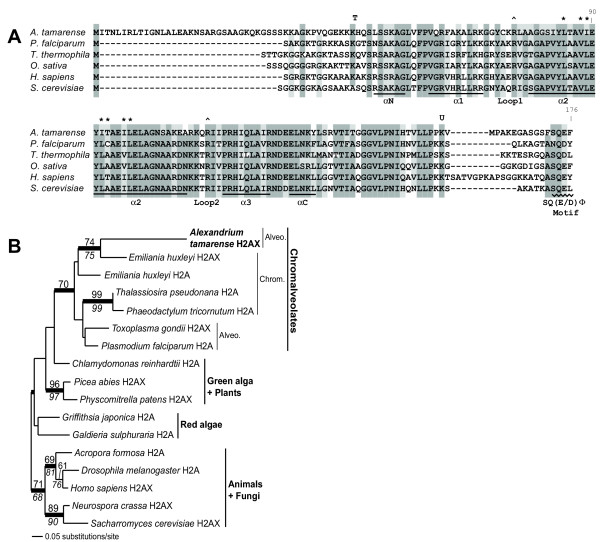
Analyses of A. tamarense histone H2A.X. A) Alignment of A. tamarense H2A.X with eukaryotic homologs. The alignment is shaded according to the level of conservation. The symbols above the alignment indicate the location of functional residues (T = trypsin cleavage site, ^ = arginines that contact the DNA helix, * = H2A-H2B interaction sites, U = ubiquitination site). The annotation below the alignment indicates conserved structural features including the α-helices, loops, and the SQ(E/D)Φgotif. B) A ML tree of H2A and H2A.X. The numbers above and below the branches are the results of ML and NJ bootstrap analyses, respectively. The thick branches indicate > 0.95 posterior probability from Bayesian inference. Only bootstrap values ≥ 50% are shown. Branch lengths are proportional to the number of substitutions per site (see scale bar).